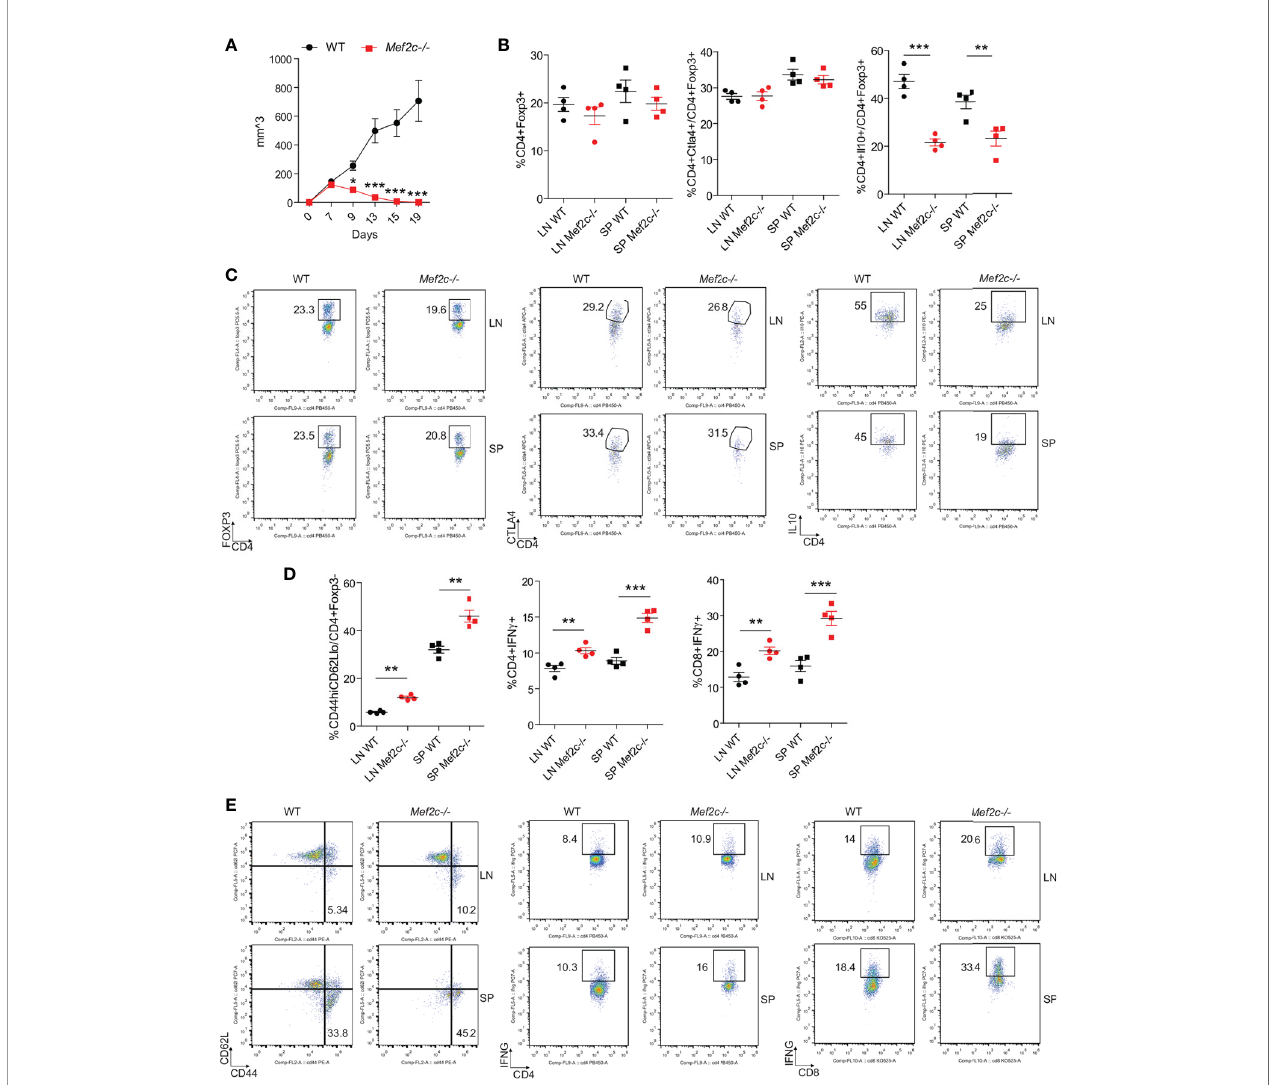
FIGURE 5 | Mef2c deletion in Foxp3+ Tregs promotes anti-cancer immunity. (A) Graphs representing the tumor growth in 10 WT and 10 Mef2c-/- mice during a 19-day-long observation period after the subcutaneous injection of 1.2x10 6 TC1 cells. The experiment was repeated twice with similar results (t-test between the two groups for each time point, *p < 0.05, ***p < 0.005). (B, C) Analysis of CD4+Foxp3+, CD4+Foxp3+Ctla4+ and CD4+Foxp3+IL-10+ populations in single-cell suspensions obtained from the draining lymph node and spleen harvested from four representative mice injected as in Figure 5 . In the case of IL-10 production, isolated cells were stimulated for 4 h with PMA/ionomycin before the staining. (n = 4, t-test between the two groups, **p < 0.01, ***p < 0.005). (D, E) Analysis of the activation status and IFN- g production in conventional CD4+ T cells and CD8+ T cells in single-cell suspensions obtained from the draining lymph node and spleen harvested from four representative mice injected as in (A) . (n = 4, t-test between the two groups, **p < 0.01, ***p <